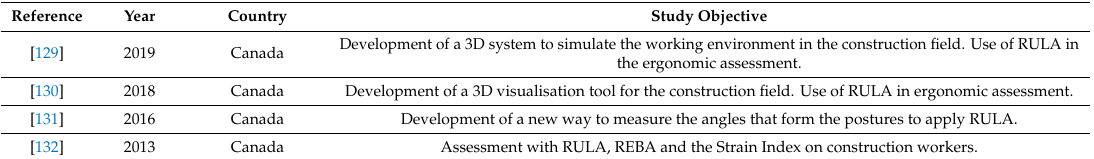
Table 7. Construction.